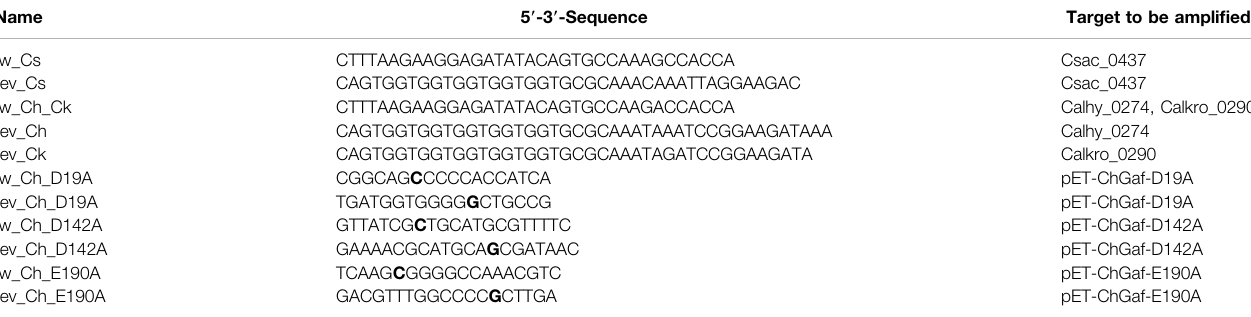
TABLE 1 | Primers for ampli fi cation of gene fragments for Gibson-Assembly and site directed